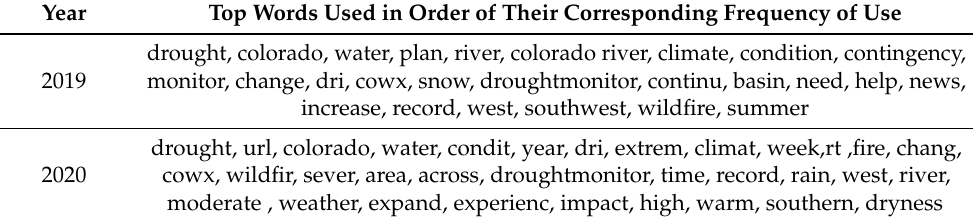
Table 1. Sample of top used words in tweets describing drought in 2019 and 2020. Root words are presented here for a better understanding. For example: [’pray’, ’praying’, ’prayer’, ’prayed’] becomes [’pray’, ’pray’, ’prayer’,